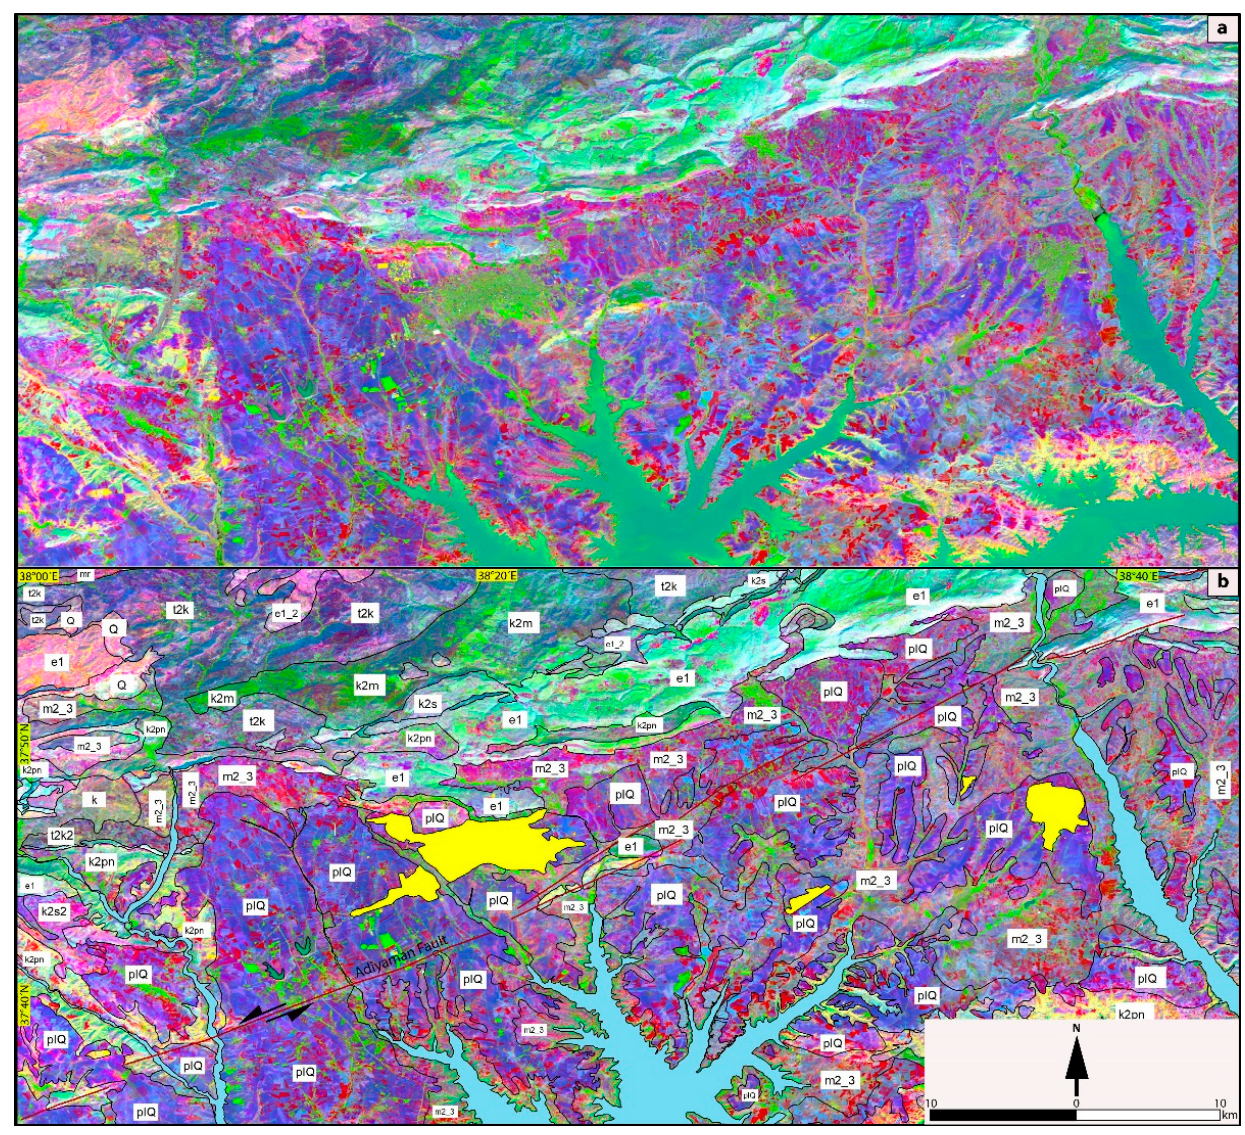
Figure 6. ( a ) Landsat 8 minimum noise fraction RGB-521 image. ( b ) MNFA image with lithological polygons. Areas of settlements are defined by yellow polygons.